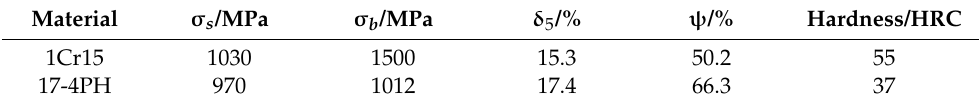
Table 2. Mechanical properties of stainless steel.